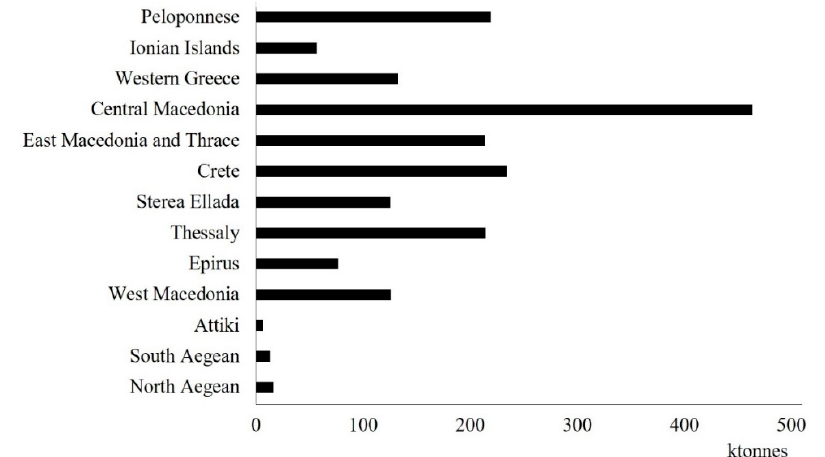
Figure 6. Potential of woody biomass (tree plantations and forests) in Greece by administrative region (ktonnes) [16].